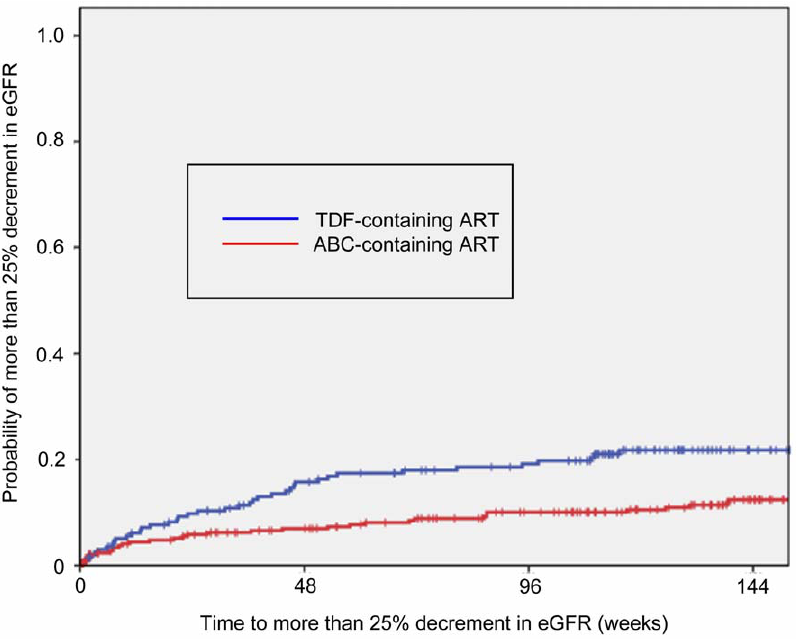
Figure 1. Kaplan-Meier curve showing the time to renal dysfunction in patients treated with TDF or ABC. Compared to treatment-naı¨ve patients who commenced treatment with ABC, those on TDF were more likely to develop . 25% fall in eGFR (p=0.001, Log-rank test). TDF: tenofovir, ABC: abacavir, ART: antiretroviral therapy, eGFR: estimated glomerular filtration rate.